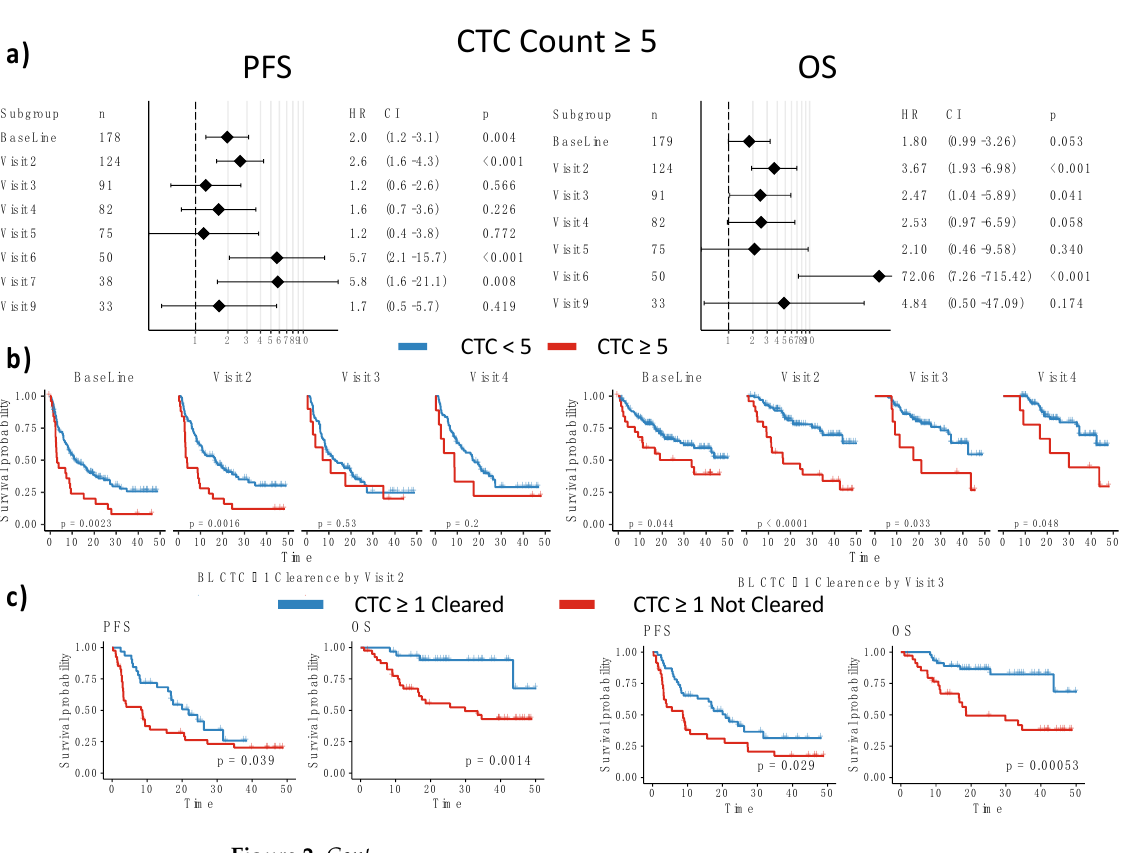
Figure 2. CTC count ≥5 is prognostic at the start of therapy for MBC. ( a ) Forest plots showing Cox proportional hazard for ≥5 CTCs/~9.5 mL of blood at each timepoint for PFS and OS. ( b ) Kaplan- Meier plots for PFS and OS stratified by ≥5 CTCs ~9.5 mL of blood. ( c ) Kaplan-Meier plots stratified by clearance of ≥5 baseline CTCs by visits 2 and 3. ( d ) Mean cumulative progression events for ≥5 CTCs vs. <5 CTCs at baseline and progression and death rates per 100 person-years. CTC, circulating tumor cell; OS, overall survival; PFS, progression-free survival. *** p < 0.0001 3.2.4. Dynamics of CTC Counts during Therapy High CTC counts can predict progression before definitive manifestation by clinical imaging. To quantify the lead time provided by high CTC counts, we measured the time to first progression in patients with ≥ 5 CTCs. There were 28 patients with ≥5 CTC s at base- line, of whom 25 progressed with a median time to progression of 2.99 months. Several patients had disease progression at or after the second visit; of the 14 patients with ≥5 CTCs at the second visit who subsequently progressed, the average time to documented clinical progression by imaging was 6.34 months after ≥5 CTCs were detected. A similar pattern emerged at 6 months (visit 3) with 20.1 months lead time, albeit with only 3 pa- tients with CTC ≥5 . Since reductions in CTC counts, representing clearance of CTC during therapy, may be indicative of therapeutic response, we looked at changes in CTC counts over time. Dy- namic longitudinal changes in CTC status with a cutoff of ≥ 5 CTCs offered similar prog- nostic value as static evaluation: decreases in CTC counts from baseline were significantly